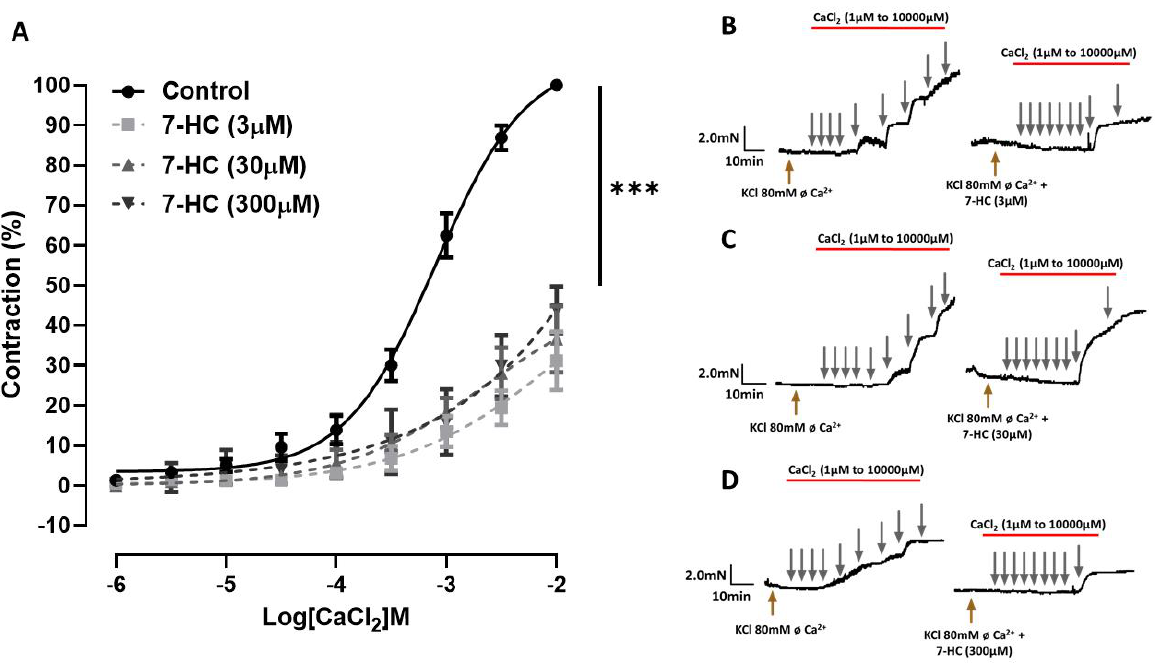
Figure 3. Effect of 7-HC on Ca 2+ influx. ( A ) Concentration – response curve of CaCl 2 on mesenteric artery segments from SHR without endothelium, in the absence ( ●, n = 15) or in the presence of 7-HC ( ■ , 3 μM, n = 5; ▲ , 30 μM, n = 5; ▼ , 300 μM, n = 5). Representative original recordings of the effects of 3 μM 7-HC ( B ) , 30 μM 7-HC ( C ) , and 300 μM 7-HC ( D ) on isolated mesenteric artery rings